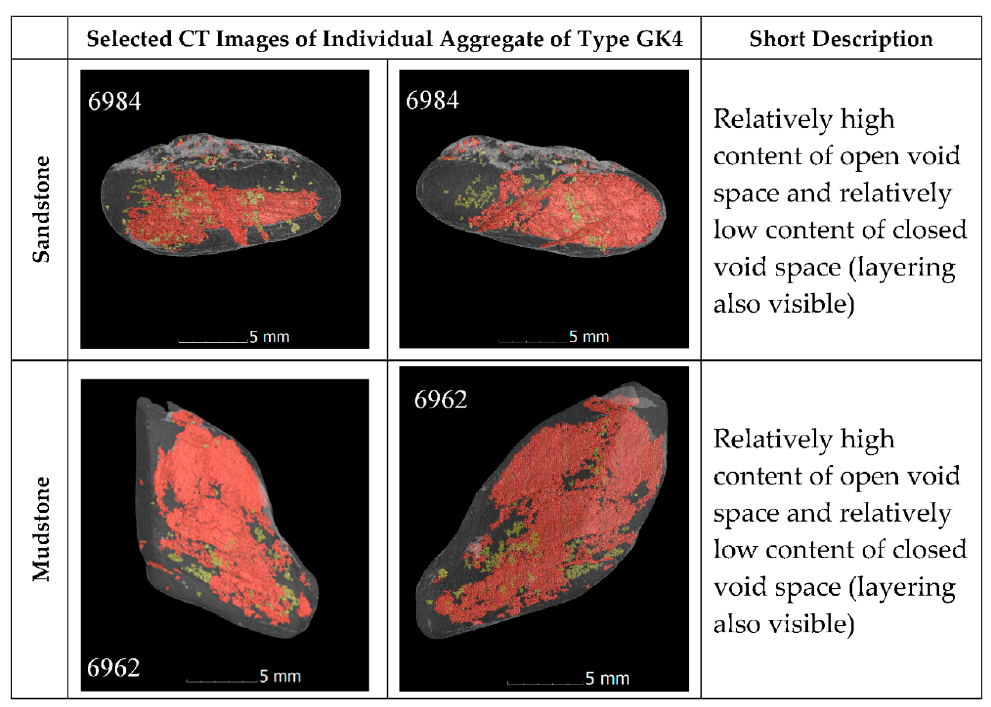
Figure A1. CT-visualizations for individual river gravel aggregate of type GK1 (the left and right images for each aggregate show views from the 0 and 90 degrees, respectively) (based on figures in [10,11]).